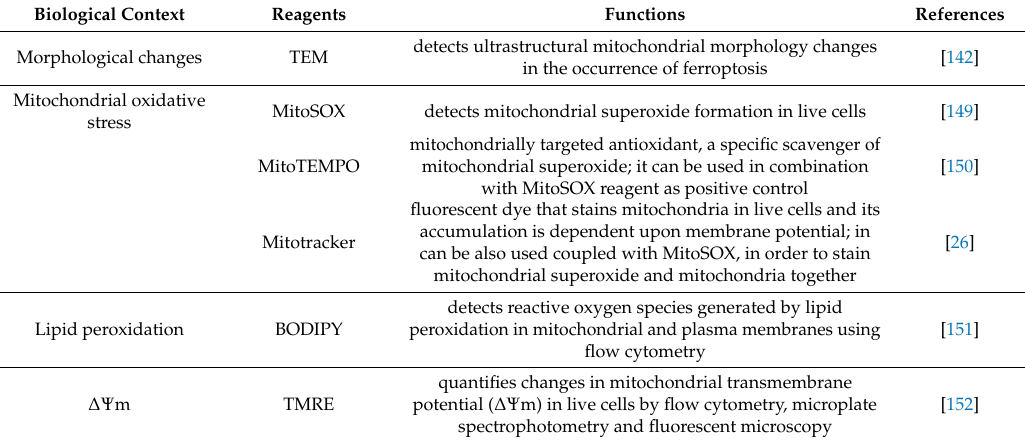
Table 3. Main methods to characterize mitochondrial function in